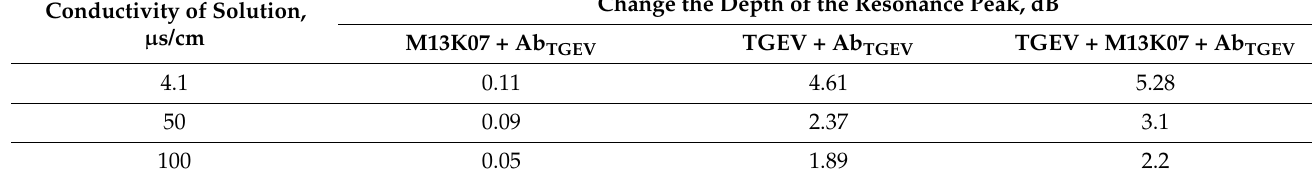
Table 2. Change in the depth of the resonant peak near the frequency of 2.82 MHz due to the addition of the antibodies specific to TGE virus in the suspension of M13K07, the suspension of TGE virus, and the mixed suspension (TGE virus and M13K07) at the various values of the conductivity of the buffer solution. Conductivity of